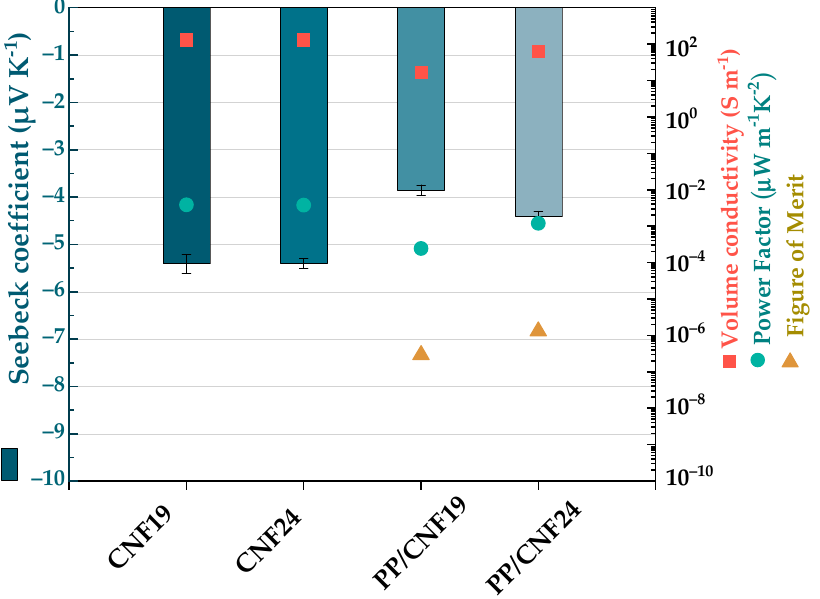
Figure 6. Electrical conductivity (squared symbols), Seebeck coefficient (bars), power factor (circle symbols), and figure of merit (triangle symbols) at 40 °C of CNFs and PP/CNF composites. (Data for CNF19 and PP/CNF19 taken with permission from ref. [15]. Data of CNF 24 taken with permission from ref. [21]). Table 4. Electrical conductivity σ , Seebeck coefficient S, power factor PF, thermal conductivity k, and figure of merit zT of CNFs and PP/CNF composites at 40 °C. (Data for CNF19 and PP/CNF19 taken with permission from ref. [15]. Data of CNF 24 taken with permission from ref. [21]).